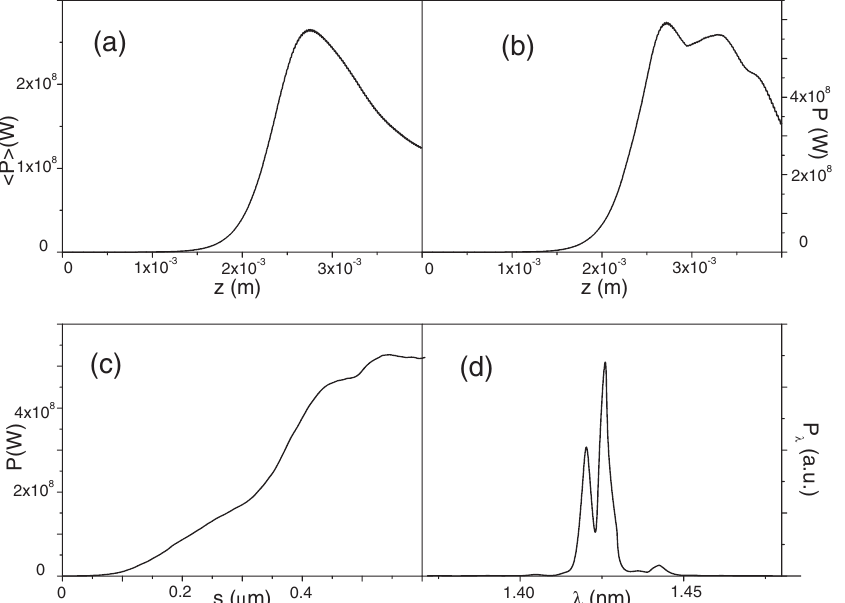
FIG. 9. (a) average power P (W) vs the coordinate along the undulator z (m); (b) peak power along z ; (c) power profile along the bunch coordinate s ( (cid:4) m ) at z (cid:6) 2 : 5 mm ; (d) power spectrum at z (cid:6) 2 : 5 mm